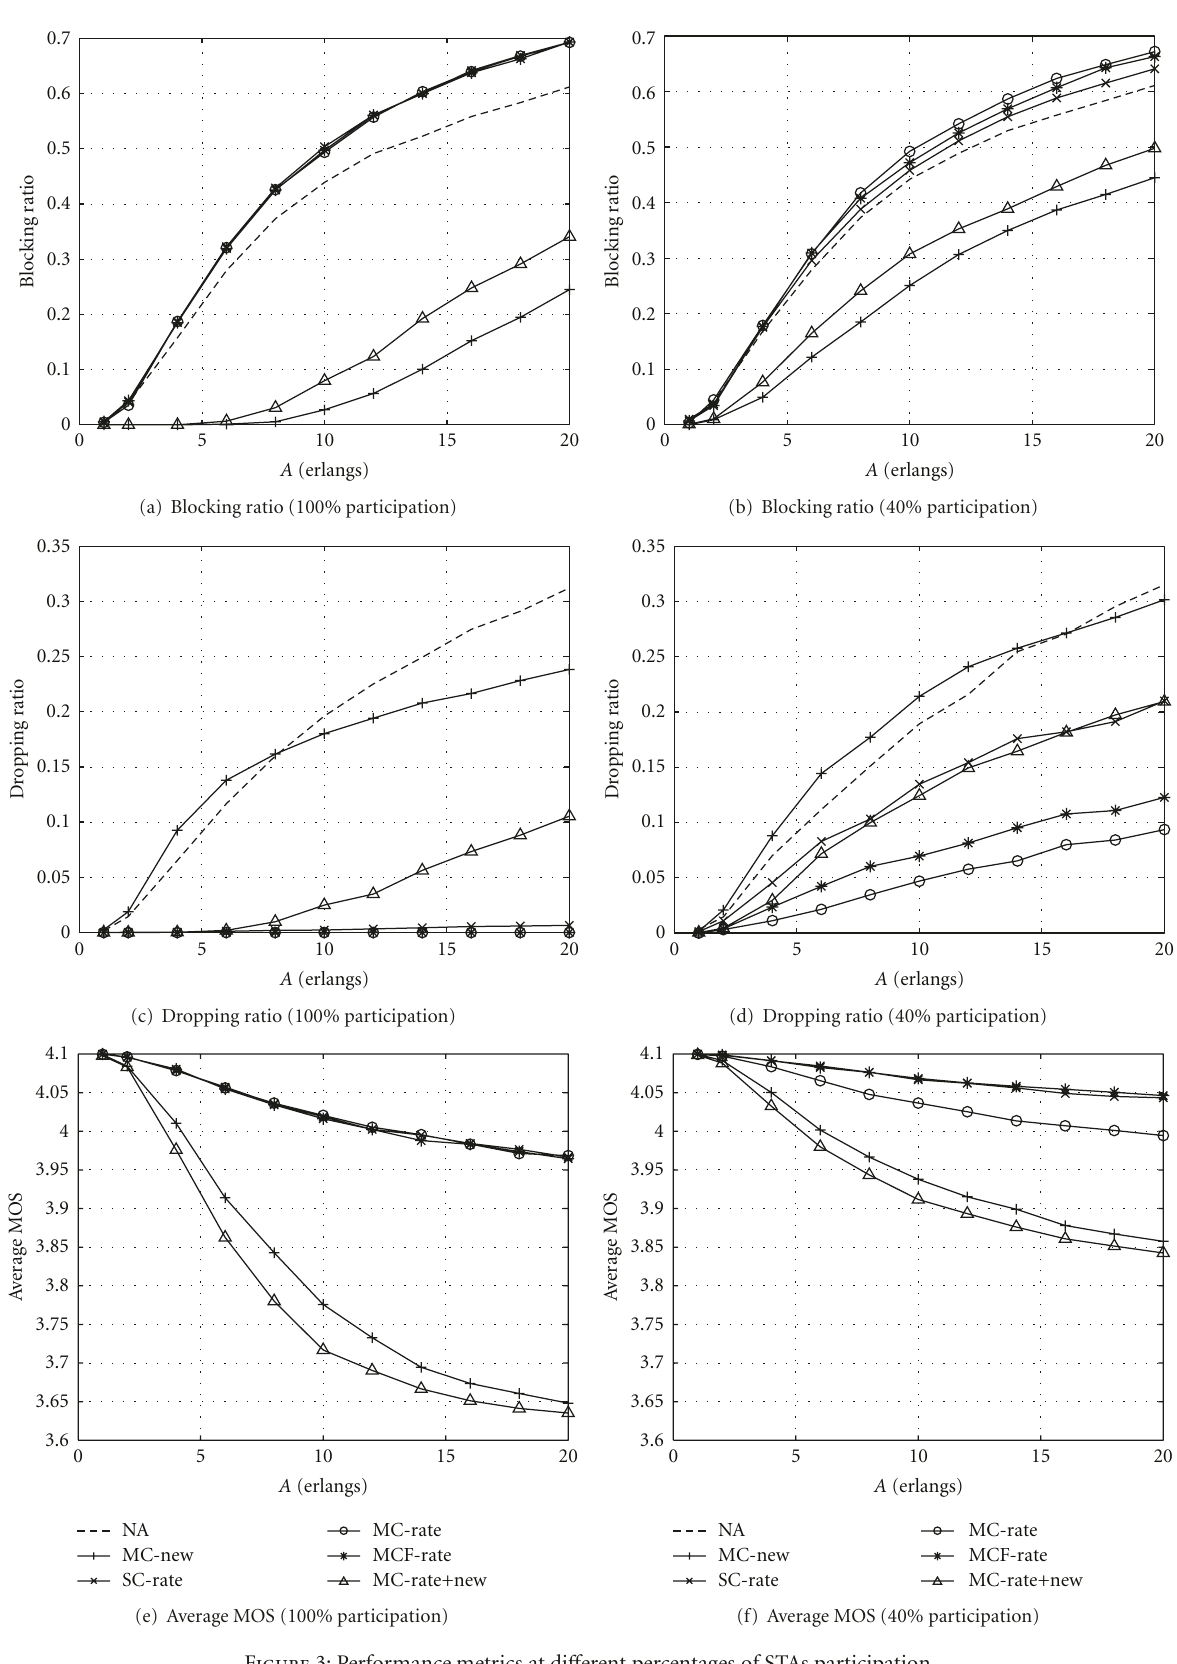
Figure 3: Performance metrics at di ff erent percentages of STAs